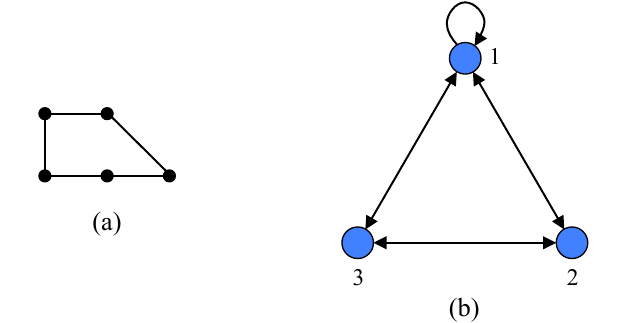
Figure 41. a) Toric diagram and b) quiver for the